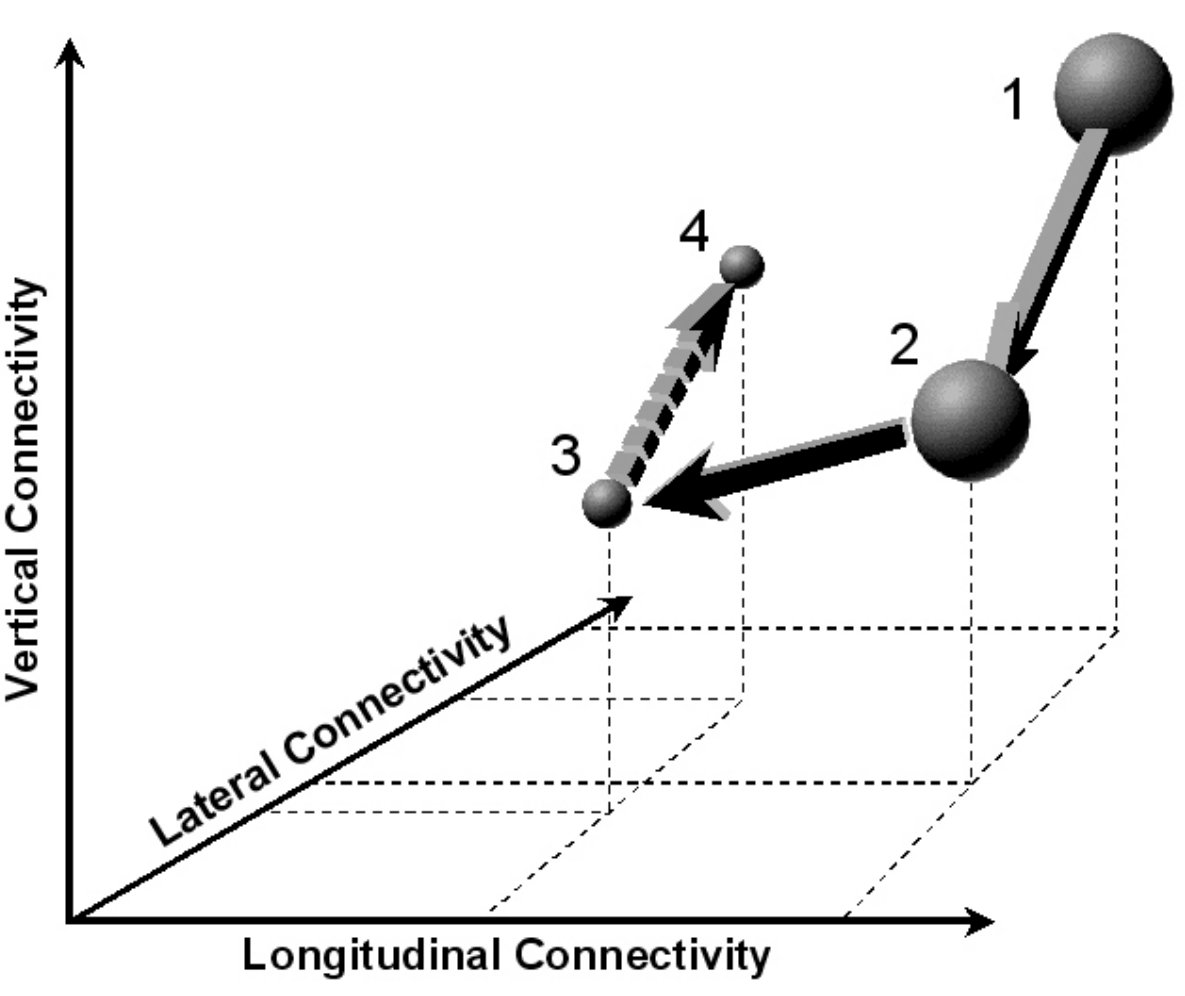
Fig. 4. Three-dimensional representation of degradation (solid arrows) and restoration (dashed arrows) trajectories for the Pite River, Sweden, based on charting the strength of longitudinal, lateral, and vertical connectivity vectors (Table 1). The size of each point represents the relative variability in annual flow resulting at each phase, 1 though 4. Phase 1 represents pre-degradation; Phase 2, channel simplification and installation of revetments starting about 1870, to facilitate transport of logs to mill; Phase 3, establishment of impoundments, ca. 1930; and Phase 4, restoration via removal of revetments and emplacing structures to recreate complex in-stream habitat, ca.